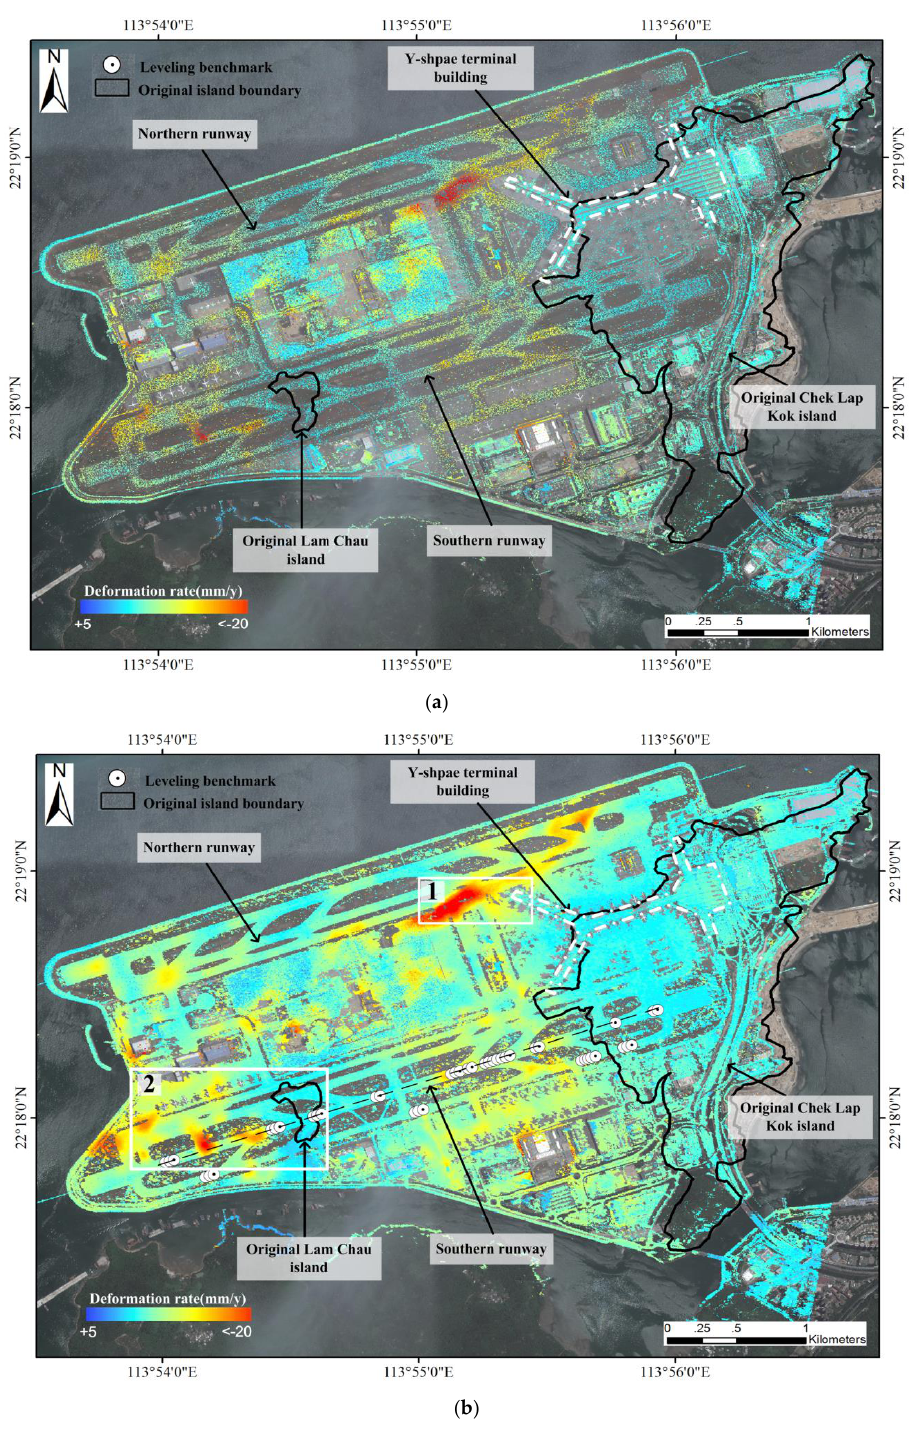
Figure 6. Comparison between the LOS velocity map [mm/yr] at HKIA from TerraSAR-X Spotlight images retrieved by ( a ) the PSI method and ( b ) the proposed DSI strategy. The white dotted line represents the boundary of the Y-shaped building.